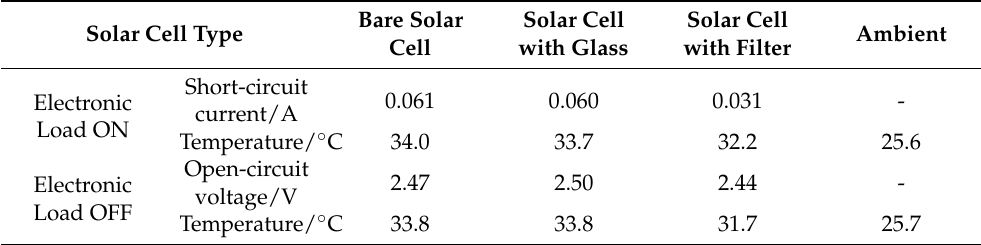
Table 7. Test results of different types of solar